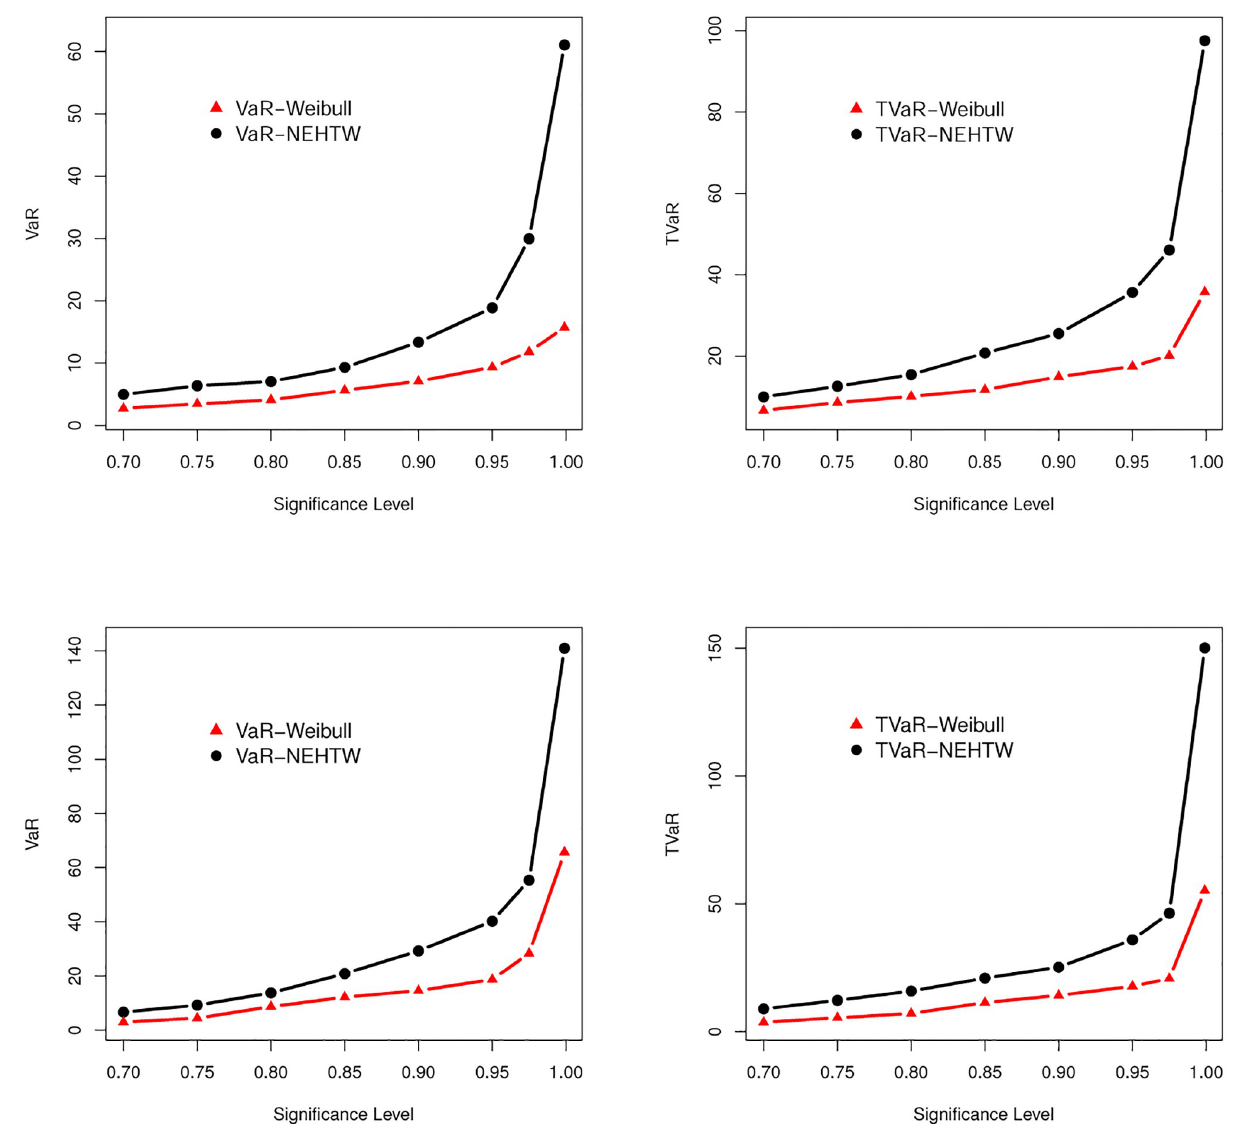
Fig 9. Graphical representation of the results provided in Tables 13 and